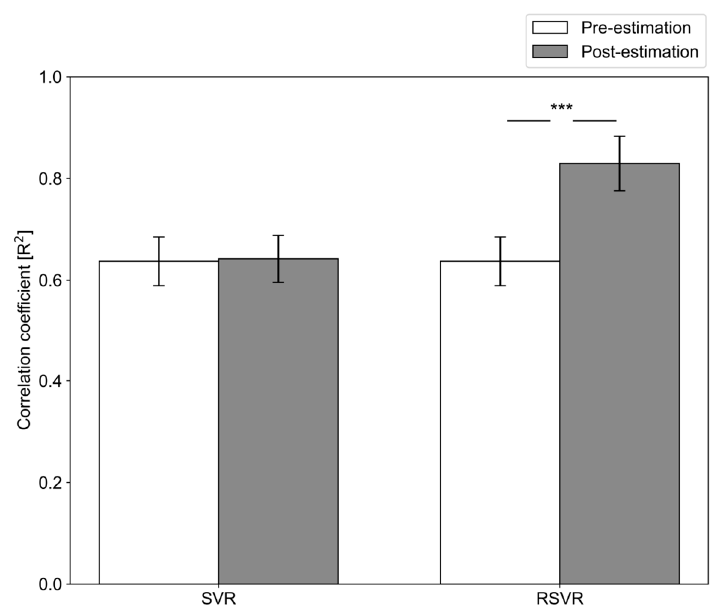
Figure 4. Statistical analysis of the correlation coefficients of pre- and post-trial estimation performed using SVR (without proposed method) and RSVR (with proposed method) (***: p < 0.001, **: p < 0.01, *: p < 0.05).